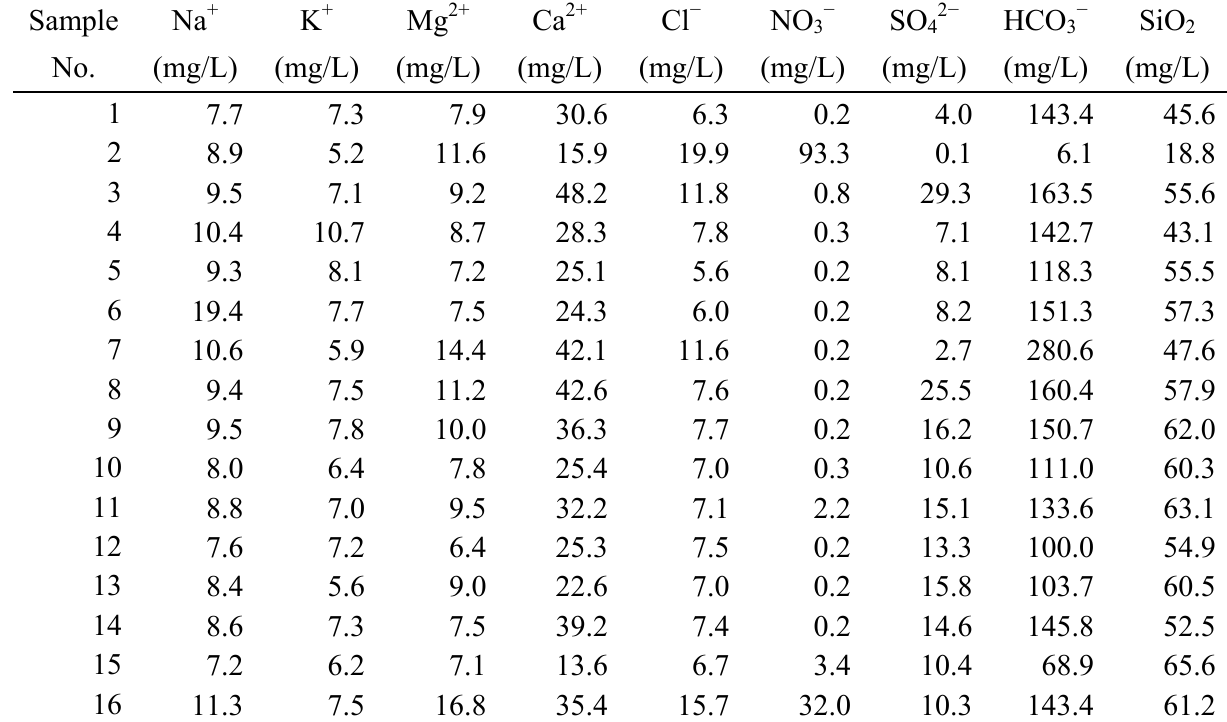
Table 2. Dissolved major ions and silica concentrations in groundwater from the Yoro River basin. Sample